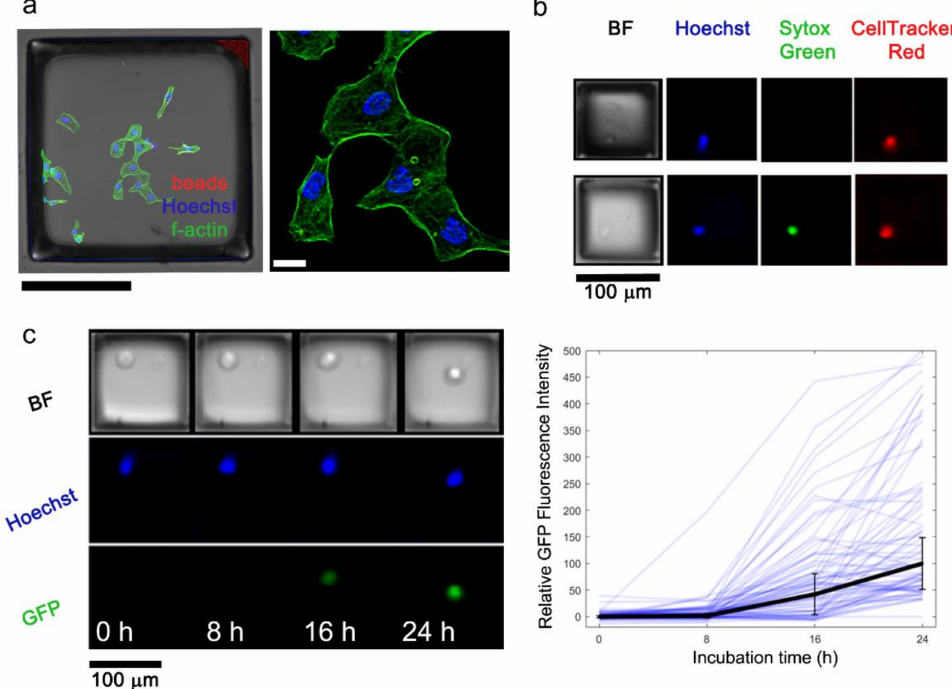
Figure 4. Technical demonstration of bioimaging assay applications on magnetic polystyrene EMAs. ( a ) Composite brightfield and fluorescence confocal microscopy composite image of fixed adherent A-431 cells (left); magnified view of a maximum intensity projection with subcellular fluorescence resolution (right). Black scale bar: 250 µ m; white scale bar: 20 µ m. ( b ) Representative widefield microscopy images of non-adherent Jurkat cells from fluorescence viability assays. ( c ) Representative widefield microscopy images (left) and all N = 257 activated single-cell fluorescence profiles (right) showing the increasing fluorescence of a GFP reporter in non-adherent J-Lat 6.3 cells. The solid black trace represents the median values; error bars are median absolute deviations. Microstructures in panels ( a – c ) were prepared with the rotational method, evaporative method, and swirling method,